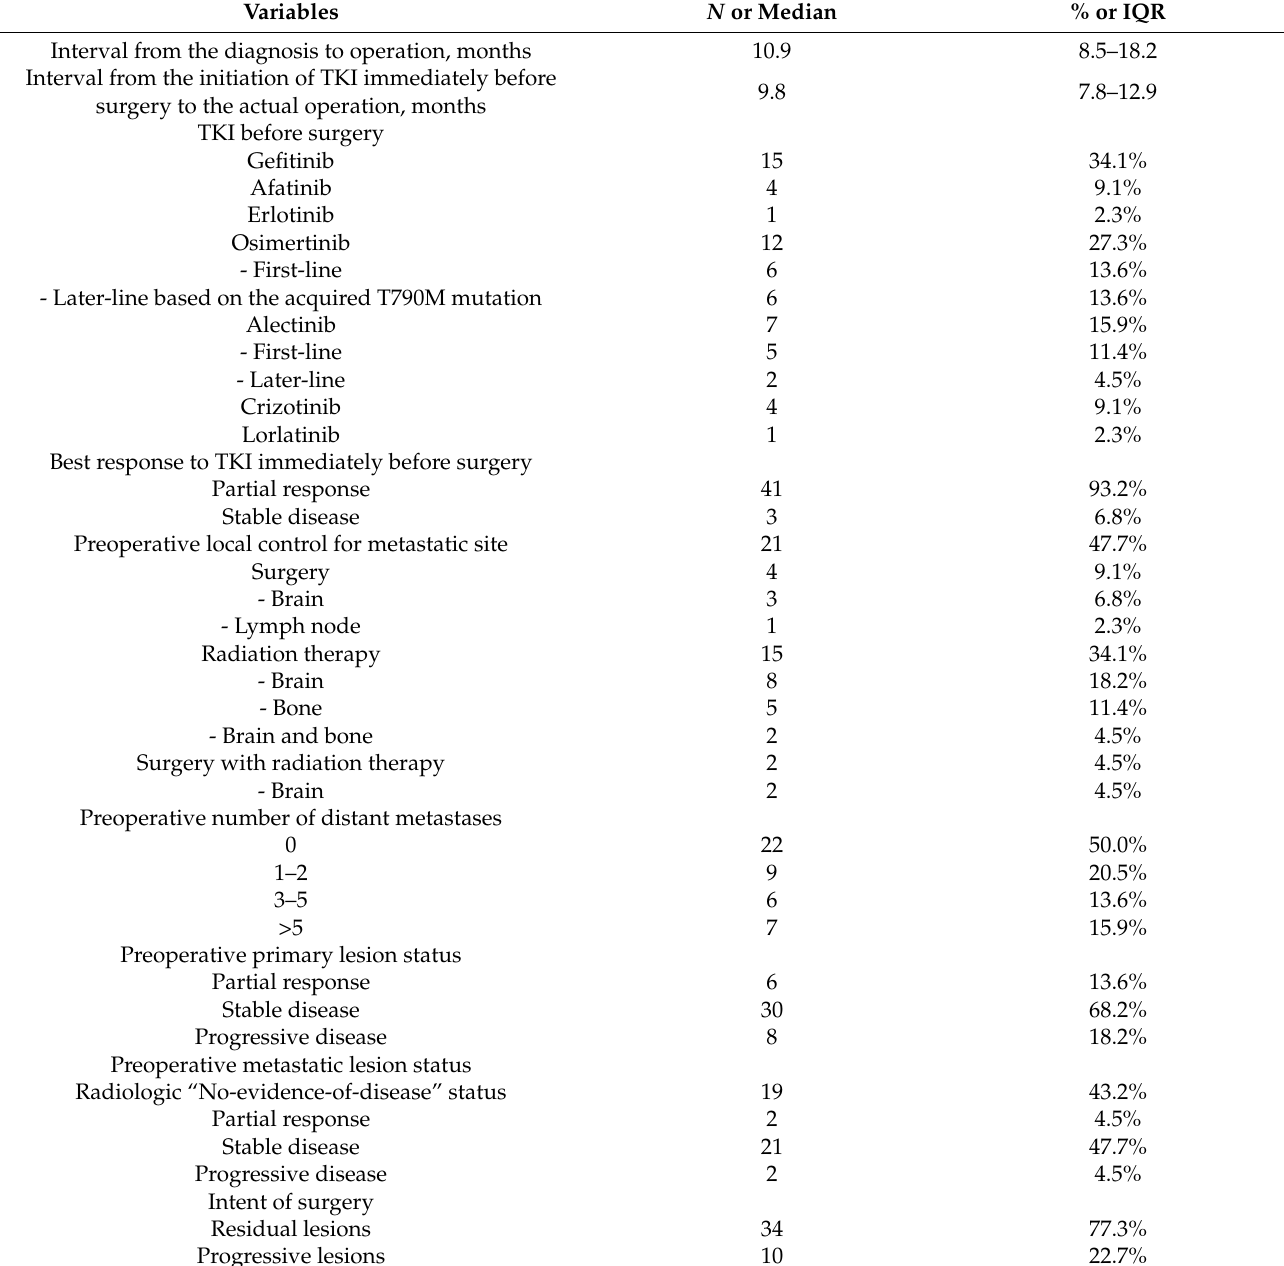
Table 2. Preoperative disease status and